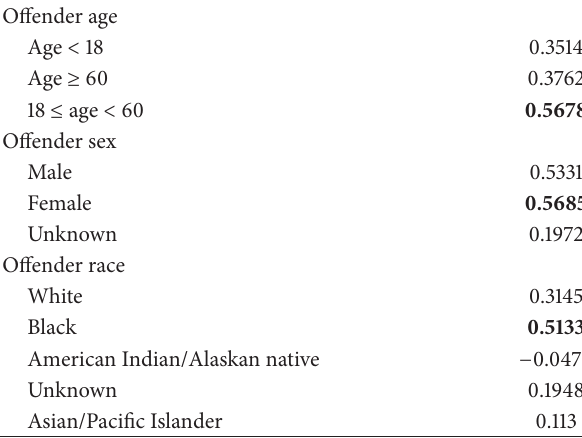
Table 6: Drug dealing correlation with other crime parameters related to offender.